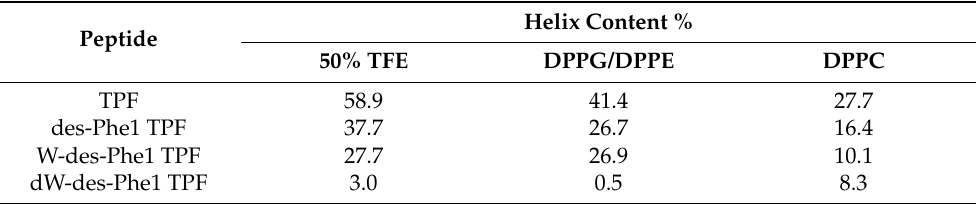
Figure 8. CD spectra of TPF and the analogs (50 μM) prepared in 10 mM NH 4 AC, 50% TFE/10 mM NH 4 AC, 3 mM DPPG/DPPE (88:12) SUVs, and 3 mM DPPC SUVs. The spectra were averaged over three consecutive scans, and the solvent CD signal was subtracted. Table 2. Helix content (%) in 50% TFE/10 mM NH 4 AC, 3 mM DPPG/DPPE (88:12), and DPPC analyzed by BeStSel (http://bestsel.elte.hu/index.php).